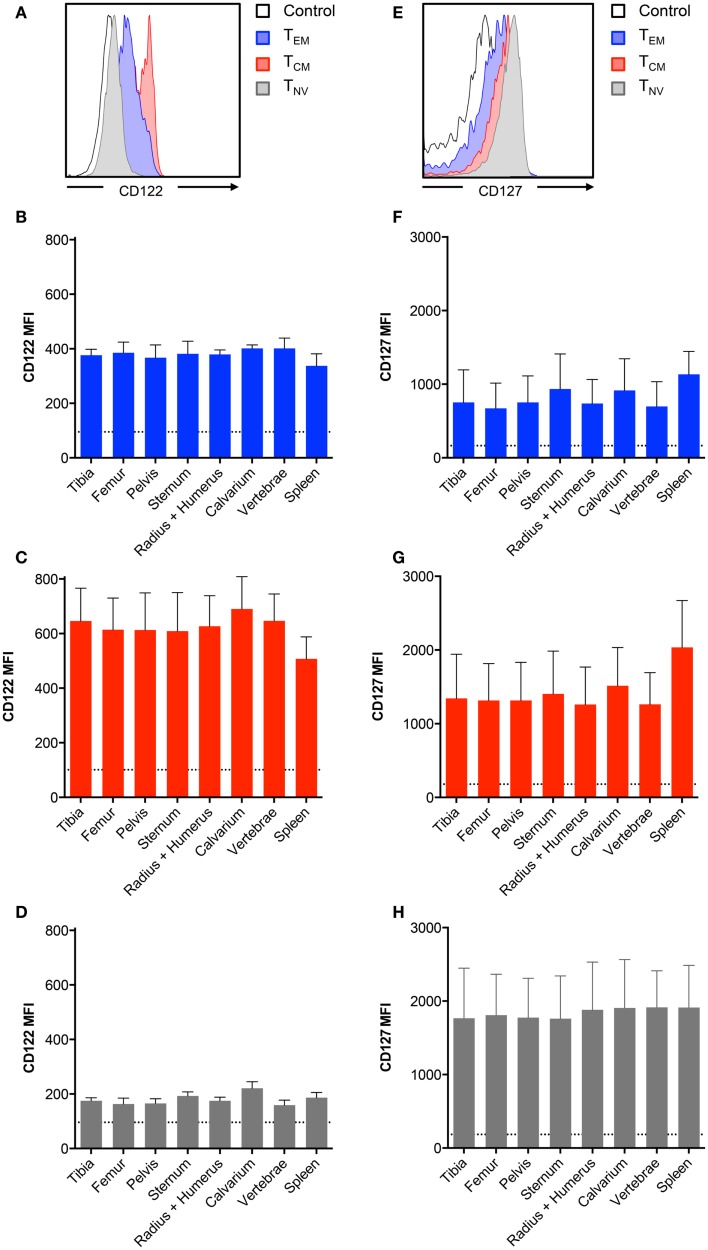
BM memory CD8+ T cell subsets differ in their expression of survival receptors. (A,E) Representative histograms showing expression of CD122 and CD127 in CD8+ TEM, TCM, and TNV subsets. Black line indicates intensity of unstained cells. (B–D) MFI of CD122 or (F–H) MFI of CD127 on TEM, TCM, and TNV subsets. Dotted line indicates MFI of unstained cells. Graphs show mean ± SD for each bone (n = 5–8).